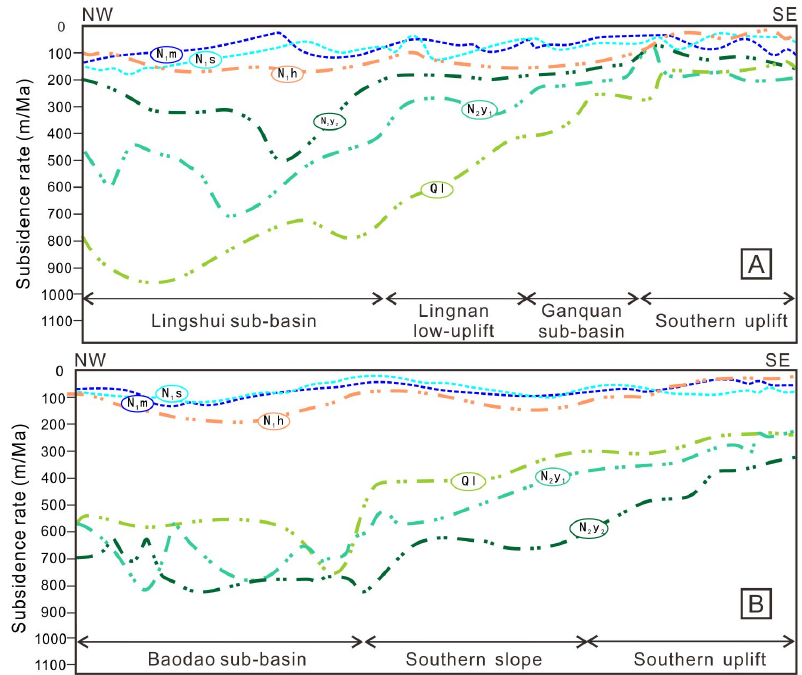
Figure 9. ( A , B ) Subsidence curves created based on the two sections traversing the Lingshui and the Baodao Sags, respectively (for location, see Figure 1). The subsidence rate was low in the period of the Sanya and Meishan deposition, then increased slightly during the period of the Huangliu Deposition, and increased sharply from the period of the Yinggehai Deposition. Moreover, the subsidence rate of the depressions is higher than that of the Southern Uplift after the period of the Huangliu Deposition. N 1 s = Sanya Fm., N 1 m = Meishan Fm.; N 1 h = Huangliu Fm.; N 2 y 1 = Lower Yinggehai Fm.; N 2 y 2 = Upper Yinggehai Fm.; Ql = Ledong Fm. Ma = Megaannus.